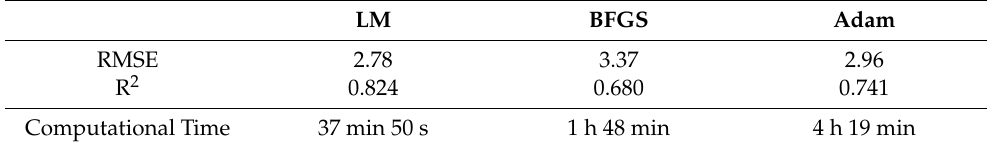
Table 3. Hyperparameter tuning—comparison of the results for the prediction of the SO 2 flow rate with three different optimization algorithms: Levenberg–Marquardt, BFGS quasi-Newton, and Adam.